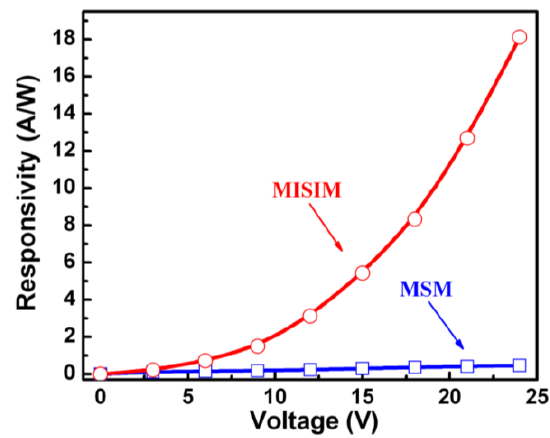
Figure 4. Responsivity of the ZnO MISIM and MSM photodetectors as a function of the applied bias.